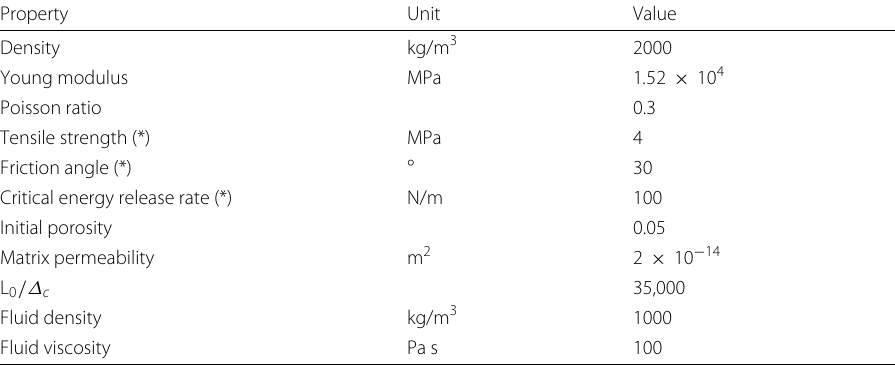
Table 1 Laboratory test